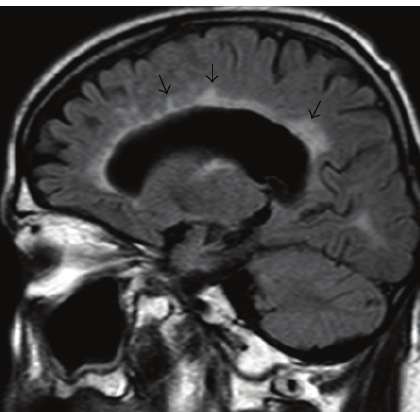
Figure 1: Left parasagittal FLAIR image of the brain of the patient at the time of his relapse (March 2012). Multiple bright white matter lesions with the long axis perpendicular to the surface of the lateral ventricle compatible with multiple